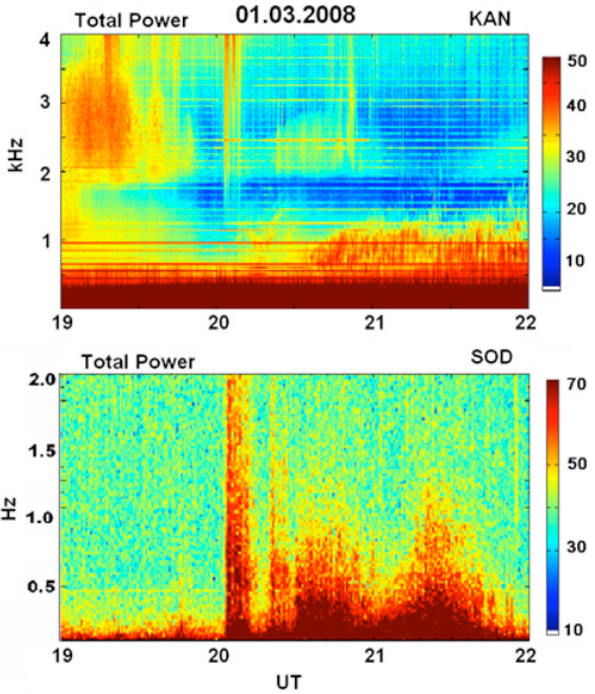
Fig. 3. Spectrograms of the event on 1 March 2008 (SOD): upper panel – chorus, bottom panel – PiB and Pi1C geomagnetic pulsa-